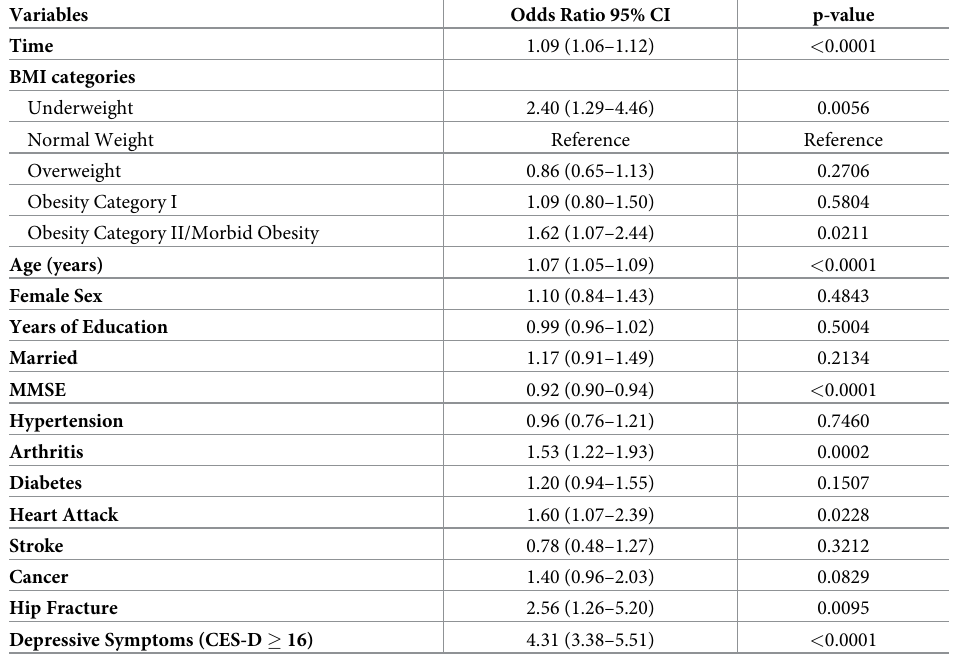
Table 2. Generalized estimating equation models for frailty as a function of BMI categories over 18-years of fol- low up among non-frail older Mexican Americans at baseline (N = 1,648).